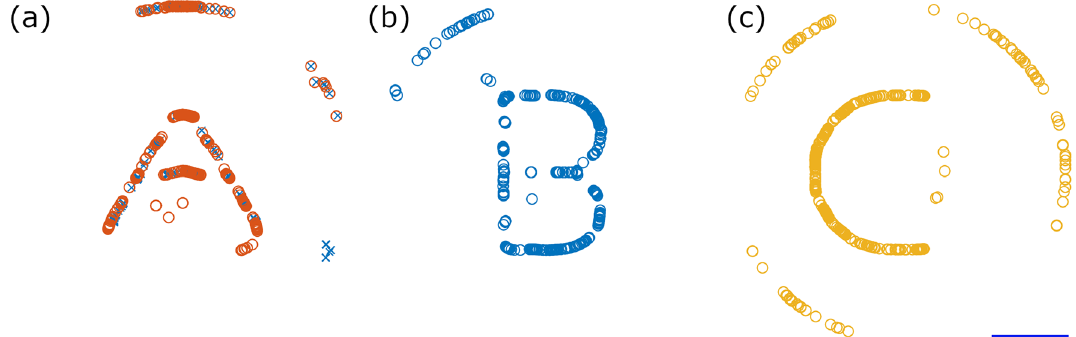
Figure 8. Simulated examples of complex particle patterns possible with the presented patterning and clearing techniques. A systematic clearing approach has been applied to the circular particle locations in all figures. ( a ) has also had custom clearing applied to remove any remaining particles with the final location indicated by the blue crosses. This was primarily achieved using an intermediate impulse vortex trap to move each particle away from the shape, then a standing wave to pull them further away. Note that the particles have been moved away but there is minimal disturbance to the coherence of the pattern. The blue scale bar is 1 mm. See Supplementary Video 5 for animations of these